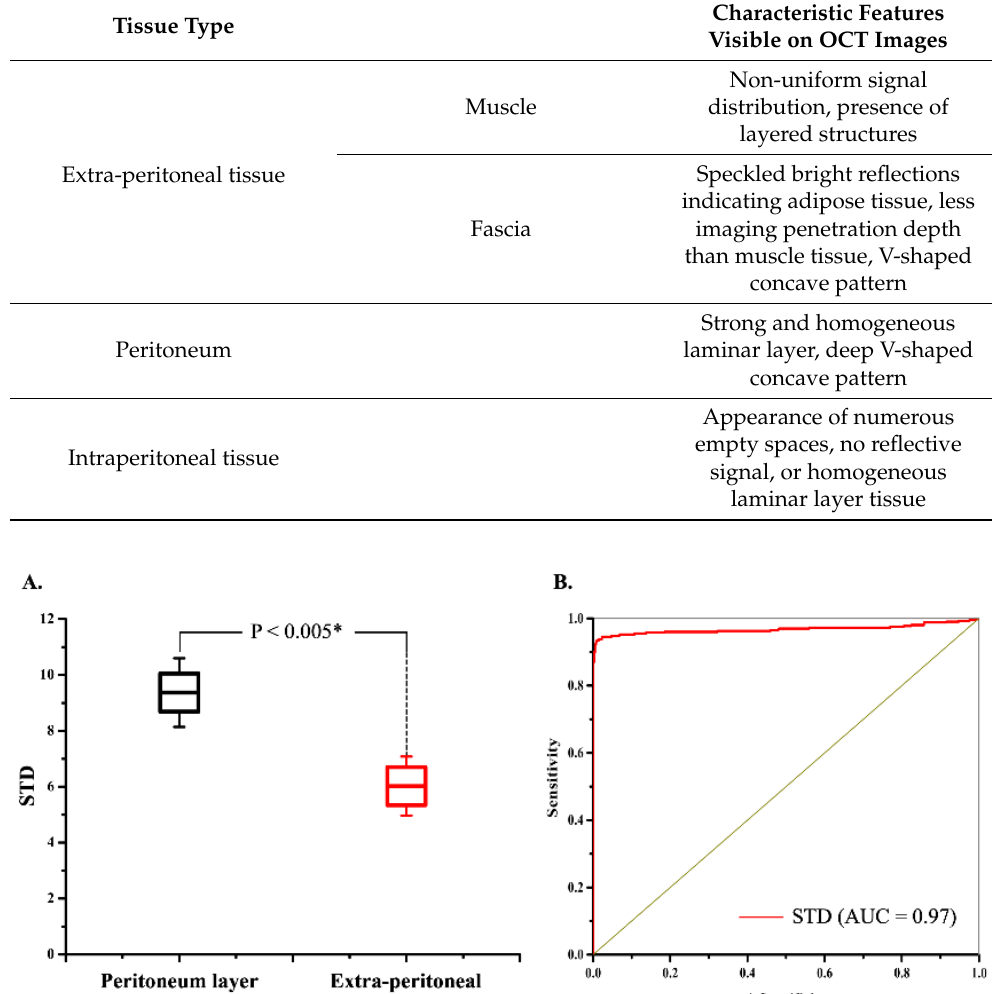
Table 1. SSOCT criteria for identifying muscle, fascia, peritoneum, and intraperitoneal tissue.